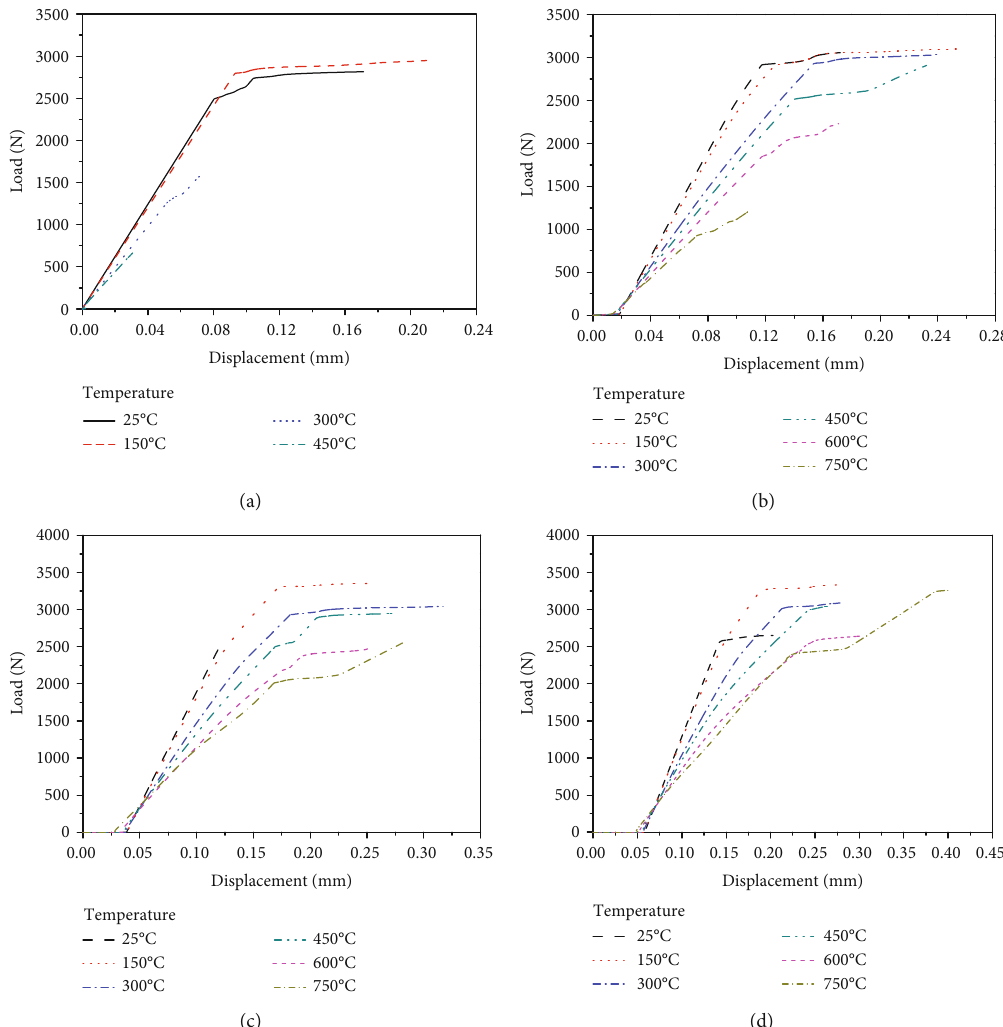
Figure 10: Load-displacement relationships for the hybrid C/SiC composite and superalloy bolted joint under various levels of bolt clearance. (a) f = 0 . (b) f = 0 : 4 % . (c) f = 0 : 8 %. (d) f = 1 : 2 %.